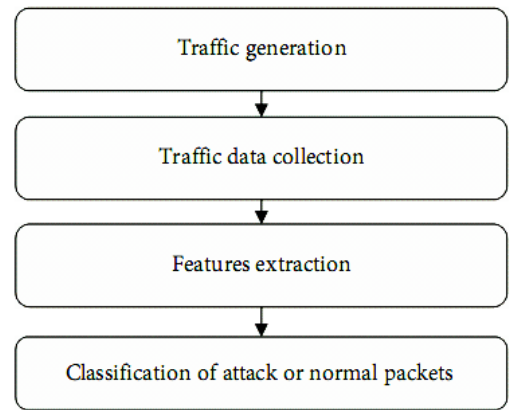
Figure 3. Modules of proposed system